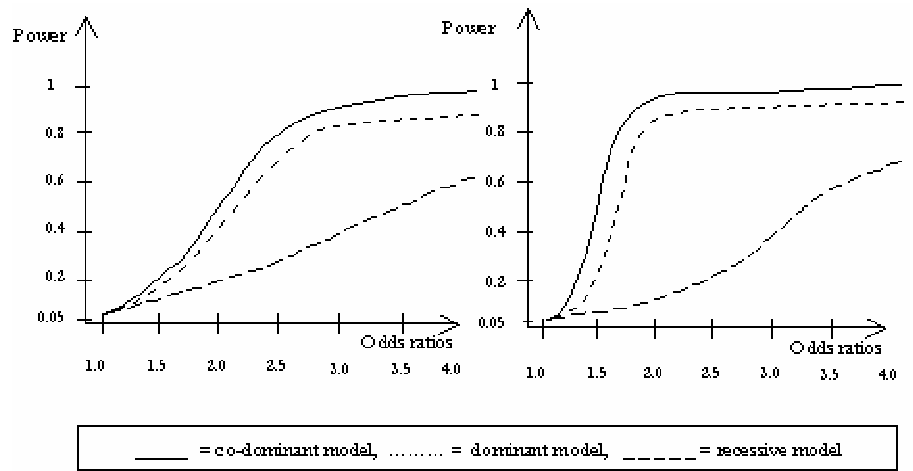
Figure 10 – Cases = controls = 100, f = 0.10. Figure 11 – Cases = controls = 500, f = 0.10.